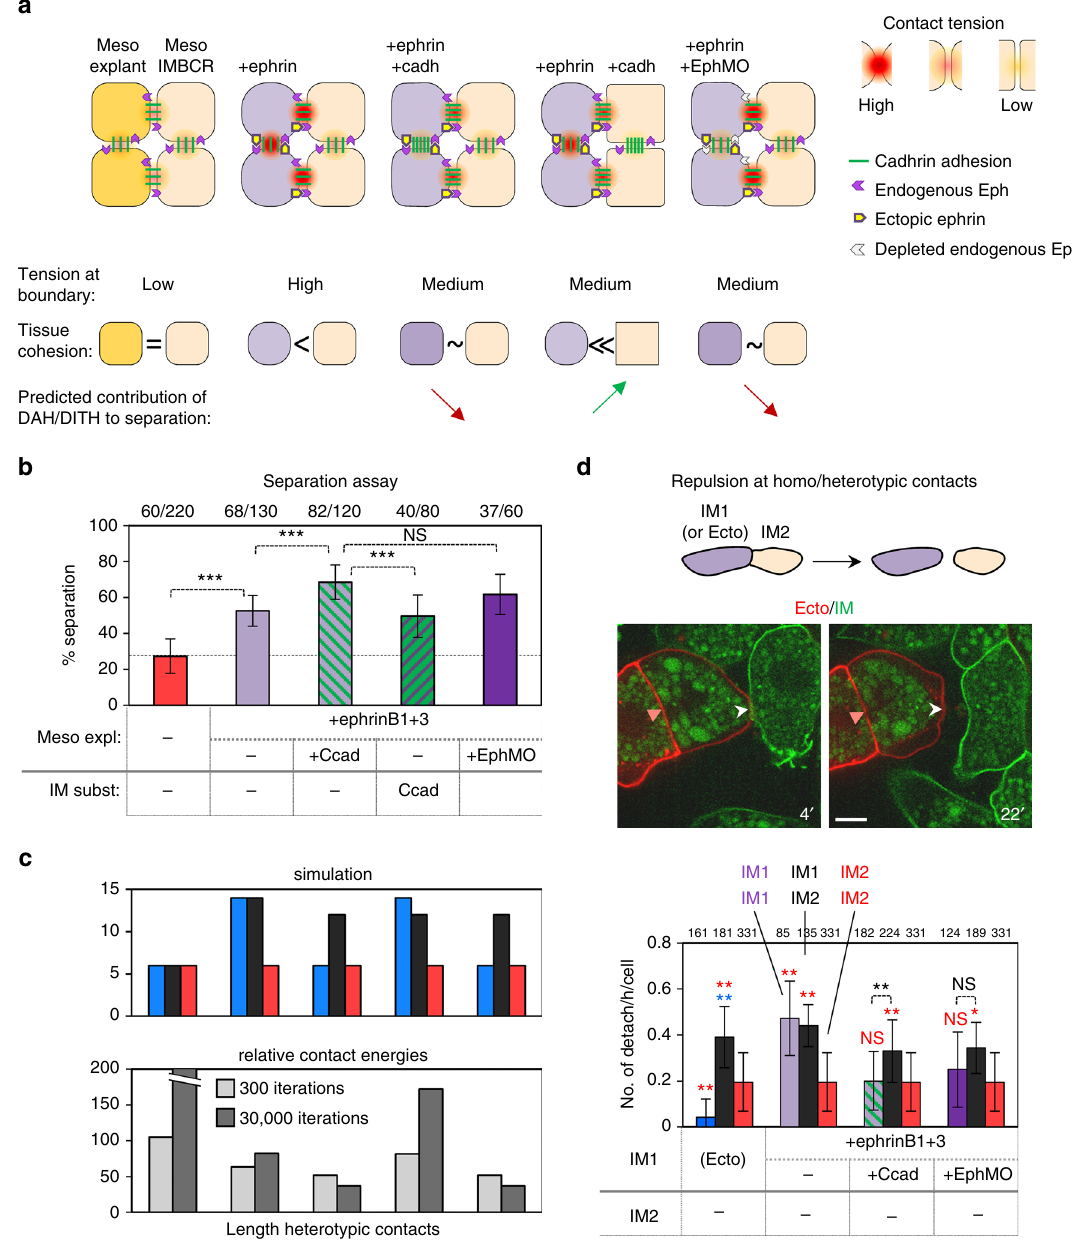
Fig. 7 Combined effects of tissue cohesion and ephrin-Eph signalling on separation. a Graphic representation of the various conditions tested in this experiment. The upper diagrams represent the various cell contacts with the tension resulting from the antagonistic action of cadherins and ephrin-Eph receptor pairs. The strength of the contact tension is also re fl ected in the shape of the cells ( rounder outlines correspond to higher tension). The lower part of the panel summarises the impact of each manipulation on heterotypic interfacial tension and on tissue cohesion (inversely related to homotypic contact tension), and the predicted effect on separation assuming a contribution of DAH/DITH. Normal mesoderm – mesoderm contacts have low contact tension. Ephrin ectopic expression stimulates repulsion both at the explant interface and within the explant, resulting in higher tension at both homotypic and heterotypic contacts. Cadherin overexpression in the explant counteracts ephrin-induced repulsion within the explant, and to a lesser degree at the interface. Cadherin expression on the other side of the boundary decreases tension in the IMBCR, thus enhancing the difference in homotypic tension of the two tissues. EphA4 depletion (EphMO) in the explant reduces ephrin-induced repulsion within the explant (and to a lesser extent at the interface). b Result of the separation assay (graph and statistics as in Fig. 4). Ephrin-induced separation was stimulated by cadherin co-expression or Eph depletion, inconsistent with a contribution of DITH. c Simulation of maintenance of separation for each experimental condition. Energy values were based on the results shown in d . The results of the simulation were in agreement with the experimental data. d Cell – cell repulsion quanti fi ed as the hourly rate of cell detachment. Top : Diagram of the experiment. Middle : Two frames of a time-lapse confocal microscopy movie. Ectoderm and IM cells expressed, respectively, membrane Cherry and membrane GFP. The pink arrowheads point to a stable homotypic contact, the white arrowheads to a heterotypic contact that detached. Scale bar, 10 µ m. Bottom : Quanti fi cation of detachments at homotypic ( blue / purple and red columns ) and heterotypic contacts ( black columns ). Statistical comparisons to ectoderm or mesoderm controls are colour coded as